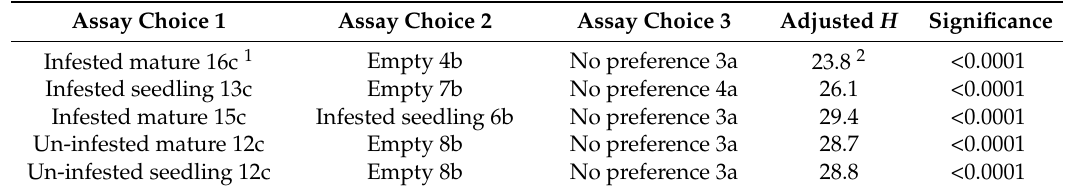
Table 2. Rhyzobius lophanthae adult search responses to Y-tube olfactometer volatiles in unfiltered